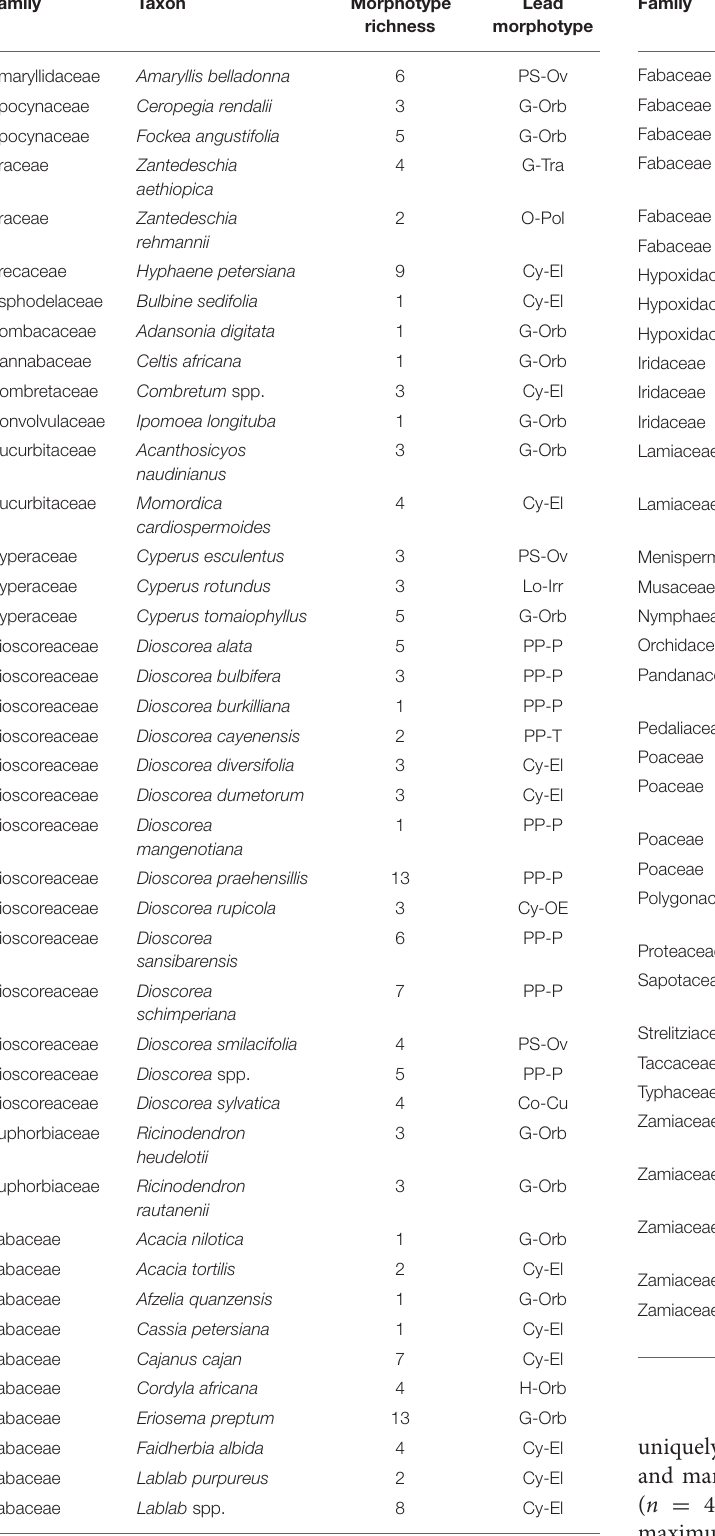
TABLE 3 | Lead morphotypes and richness per